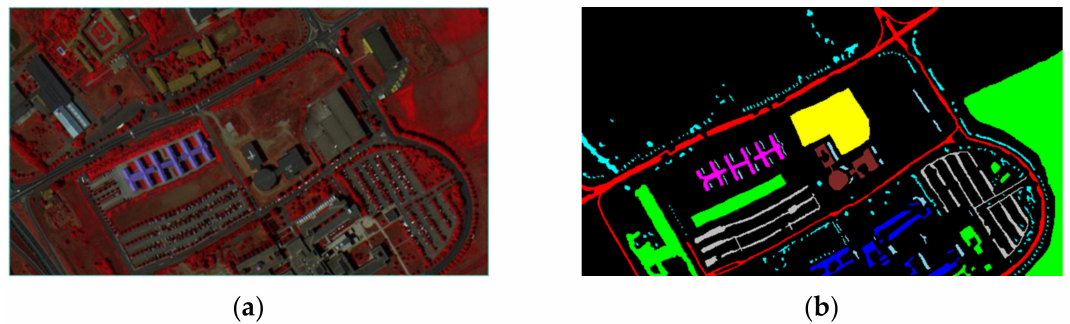
Figure 2. False-color composite map and ground truth information of the Pavia University data set: ( a ) False-color composite image; ( b ) Ground truth